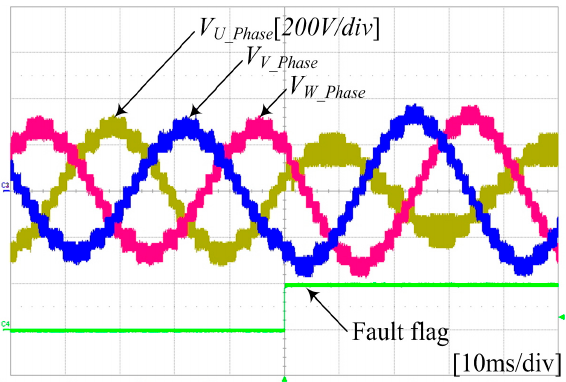
Figure 26. Experimental waveform of phase voltage applying conventional neutral-point voltage-shifting control.